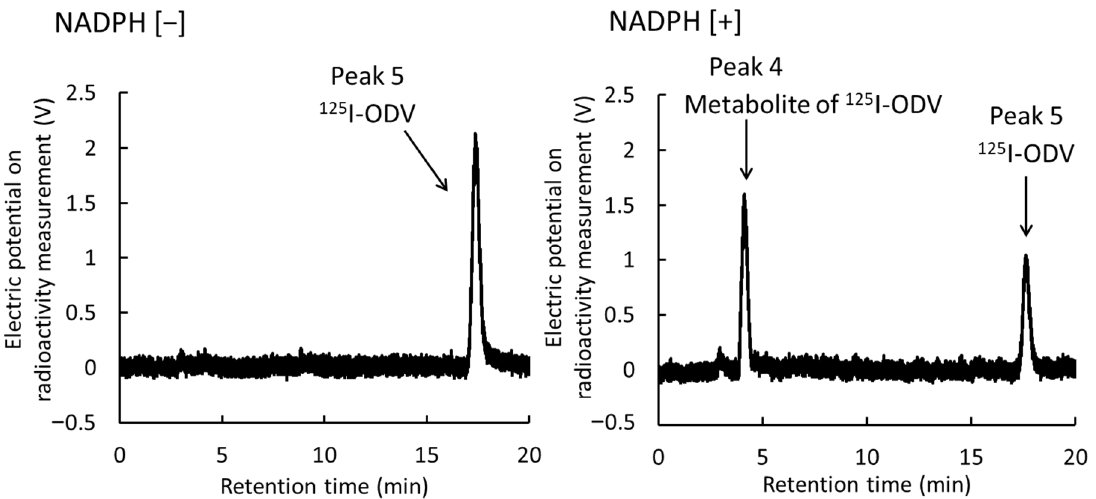
Figure 3. HPLC analysis of reaction mixtures (NADPH [ − ]/[+]). Peak 4 was not found for NADPH [ − ], so it was the metabolite of 125 I-ODV dependent on the presence of NADPH. Peak 5 was 125 I-ODV.